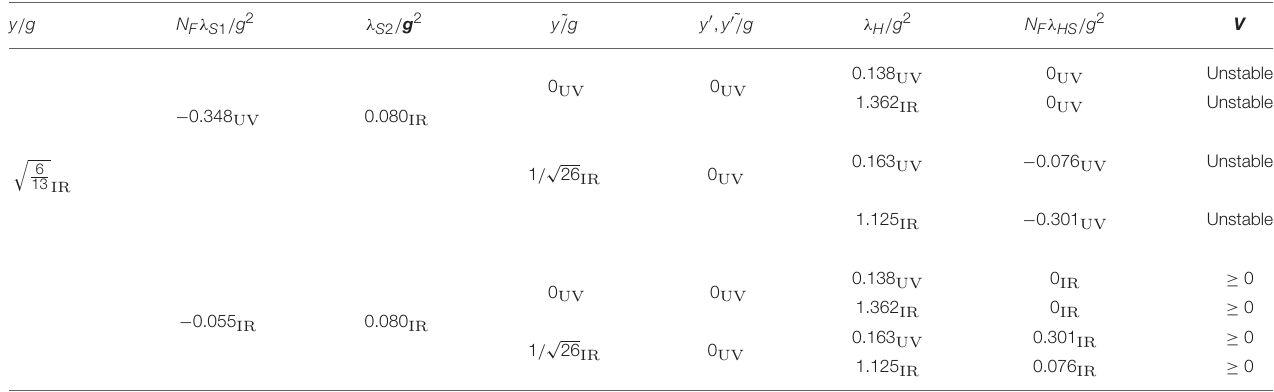
The left panel of the table refers to the Litim-Sannino model; the right panel to the extra couplings. All fixed points have g The pedix UV denotes an UV-attractive fixed point; while IR denotes an IR-attractive fixed point, where the low-energy value of the coupling is fixed. The equivalent solutions with exchanged are not showed.